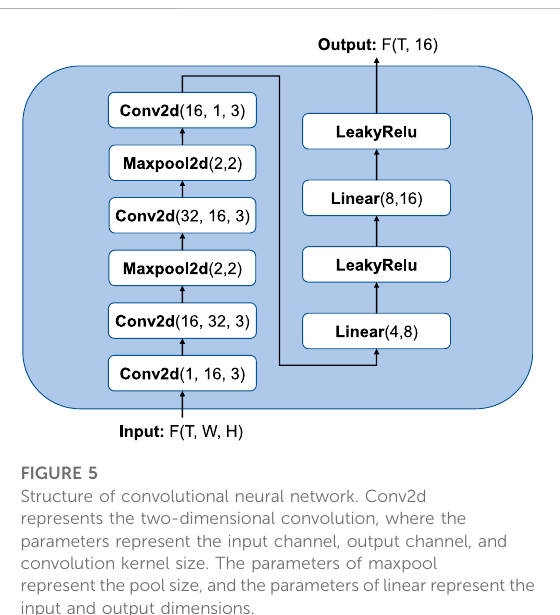
FIGURE 5 Structure of convolutional neural network. Conv2d represents the two-dimensional convolution, where the parameters represent the input channel, output channel, and convolution kernel size. The parameters of maxpool represent the pool size, and the parameters of linear represent the input and output